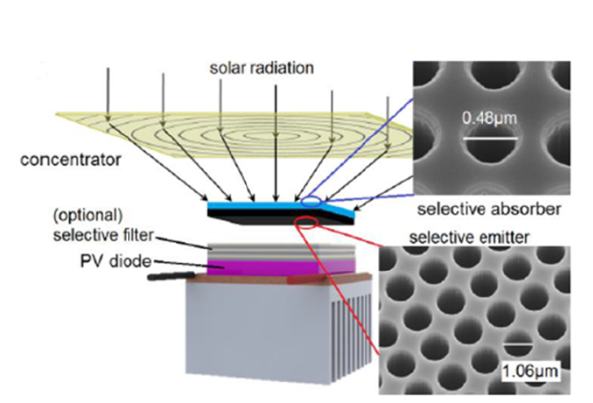
Fig. 2. Schematic of a photonic crystal-based selective solar absorber-selective emitter photovoltaic system (inset)